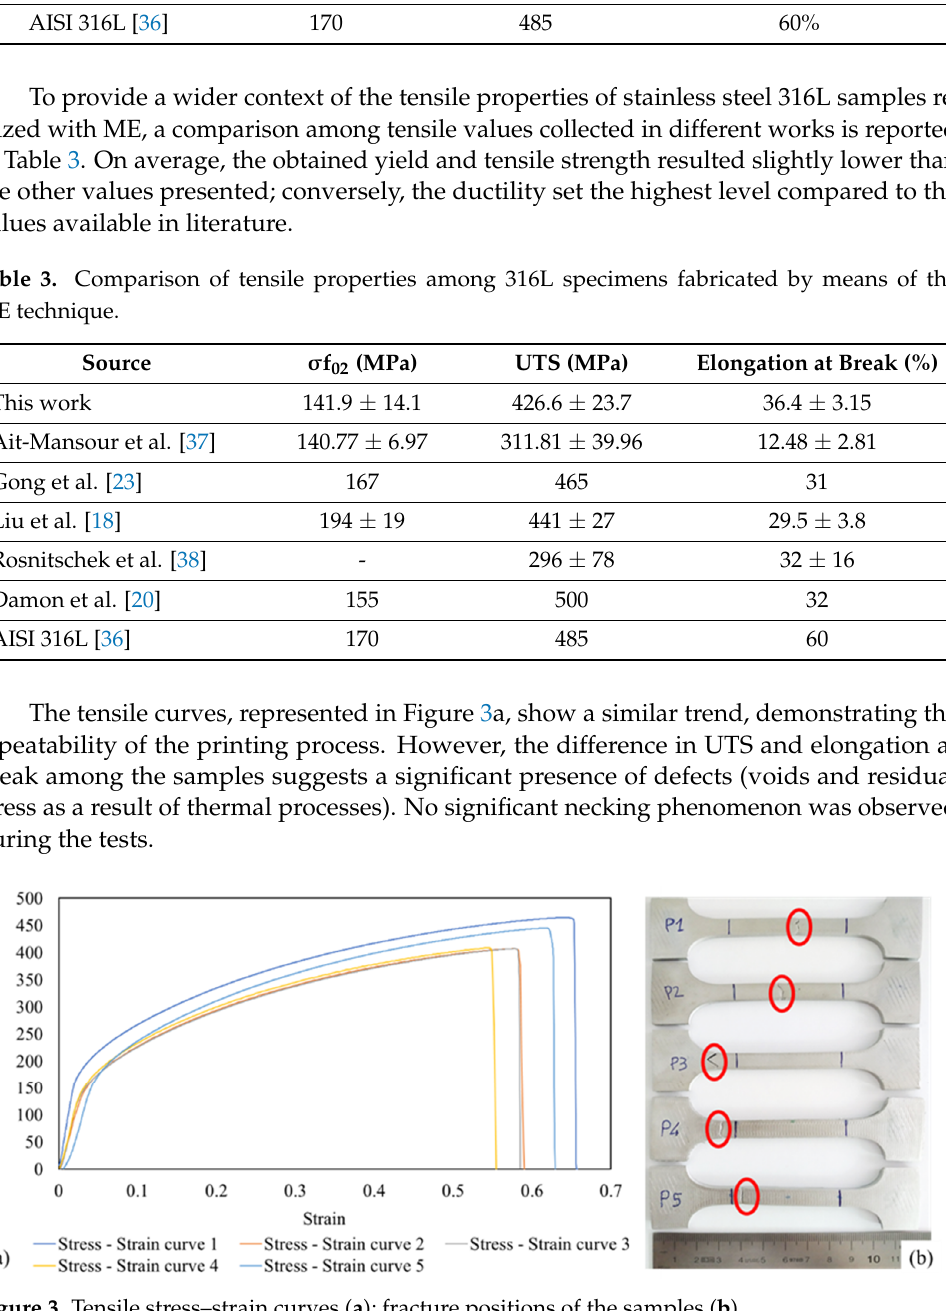
Table 2 . Tensile properties of 316L AM samples.